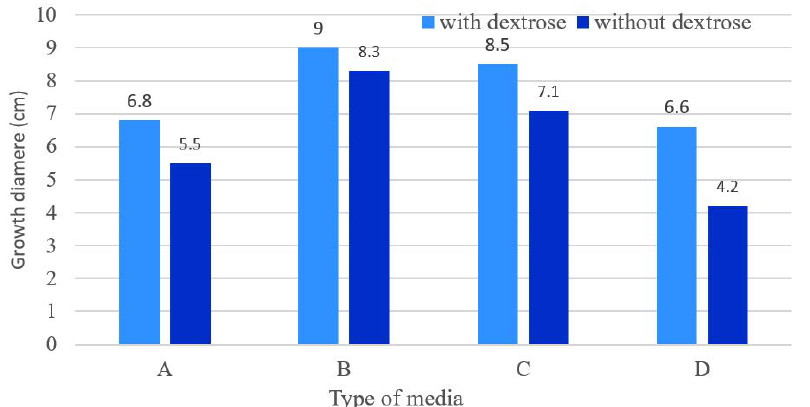
Fig. 7. Growth diameter of M. palmivorus on culture media of powdered leaves of the following plants with dextrose (1) and without dextrose (2): A (Wheat), B (Reed), C ( I. cylindrica ), and D (PDA) after 4 days of incubation at 30 o C.